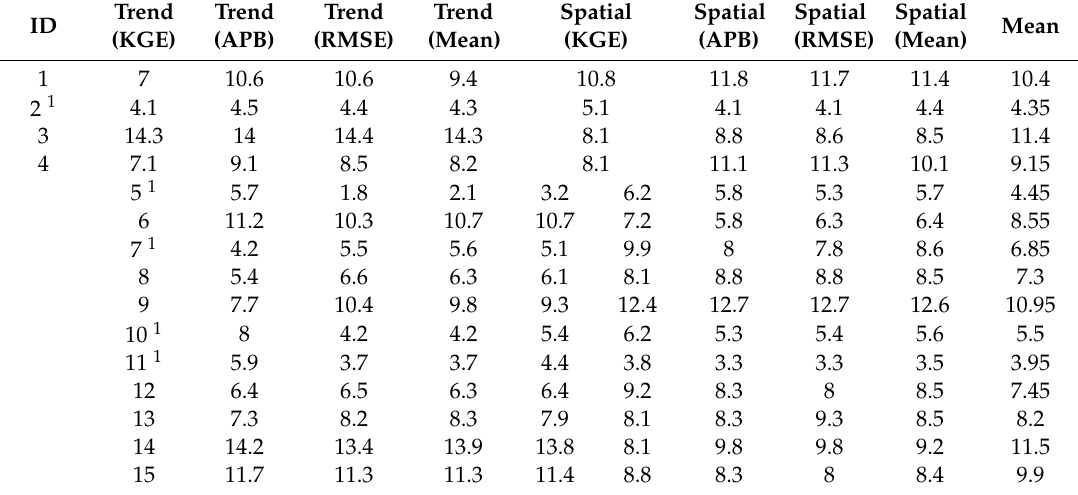
Table A2. Ranking of climate models (average of RCP 4.5 & RCP 8.5). The model ID corresponds to Table 3.